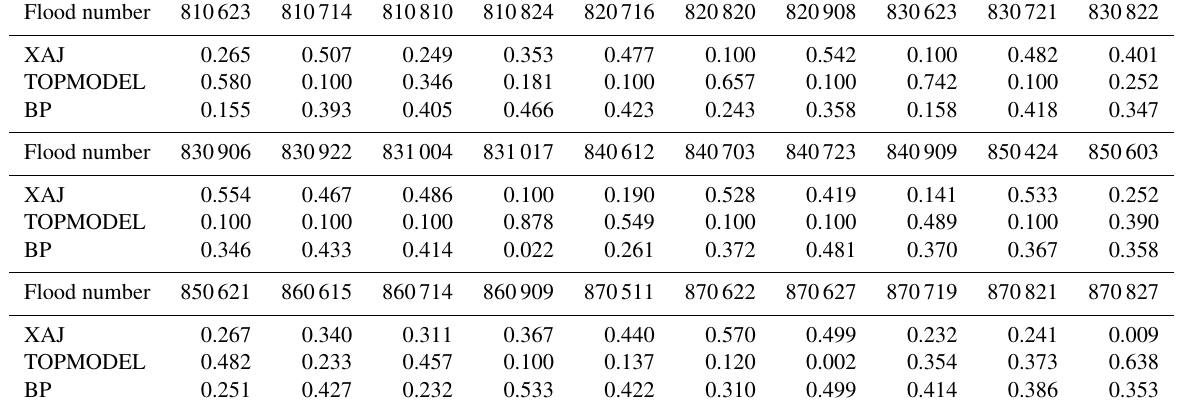
Table 5. Statistics of evaluation indexes. Average Relative Relative errors Errors